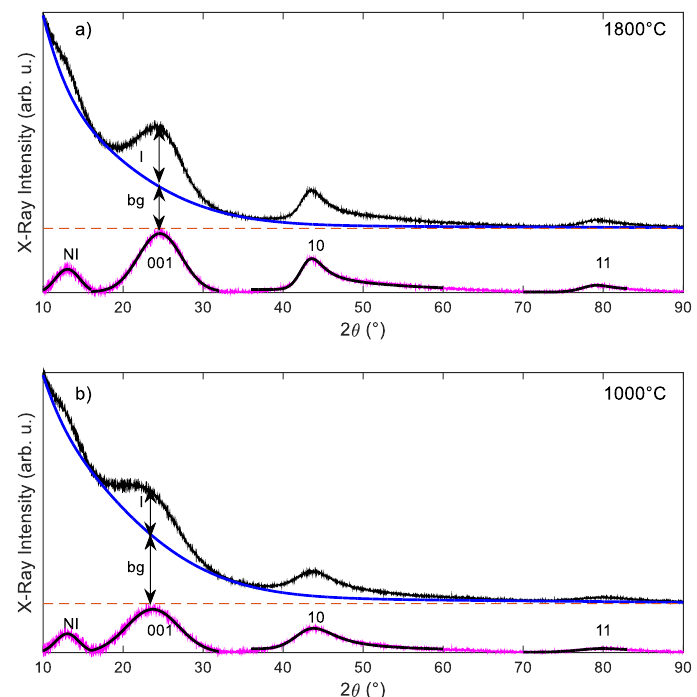
Figure 1. Raw and fitted X-ray diffraction profiles after background removal for cellulose-derived carbons obtained at ( a ) 1800 ◦ C and ( b ) 1000 ◦ C at a heating rate of 2 ◦ /min. Black curves for the diffractograms without background are the resulting fitting lines, obtained by the method described in [11]. Table 3. XRD parameters for cellulose-derived carbons at different carbonization temperatures. * From the Bragg’s law without correction, corresponding to the apparent intergraphene spacing, ** with correction corresponding to the true intergraphene spacing (see